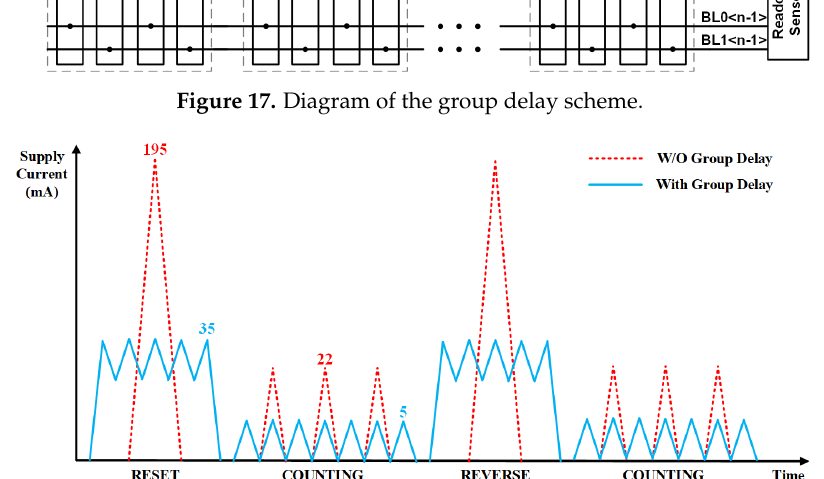
Figure 18. Simulation result of the supply